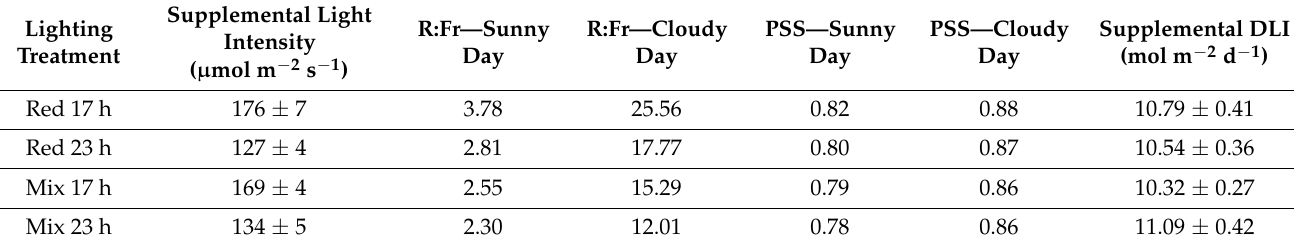
Figure 1. Normalized photon flux density (380–780 nm) from red and mixed LED lighting treatments during both sunny and cloudy days. The spectra were measured using a Li-180 Spectrometer (Li-COR Inc., Lincoln, NE, USA) at a distance of 80 cm from the light fixtures. Measurements for sunny days were done on 11 February 2019 and cloudy days on 14 February 2019 between 12:00 and 14:00. Panel ( A ) represents spectra from both red light treatments during sunny and cloudy days. Panel ( B ) represents spectra from both mixed light treatments during sunny and cloudy days. Table 1. Photosynthetic photon flux density of supplemental lighting treatments (400–700 nm; 80 cm below the LED fixtures) as determined by using a Li-190R quantum line sensor at night. Red to far-red ratios (R:Fr) were estimated by dividing the total photons of red (600–700 nm) by the total photons of far-red (700–780 nm) during both sunny and cloudy days when the supplementary lighting fixtures were on. Phytochrome photostationary state (PSS) was calculated using Equation (1)